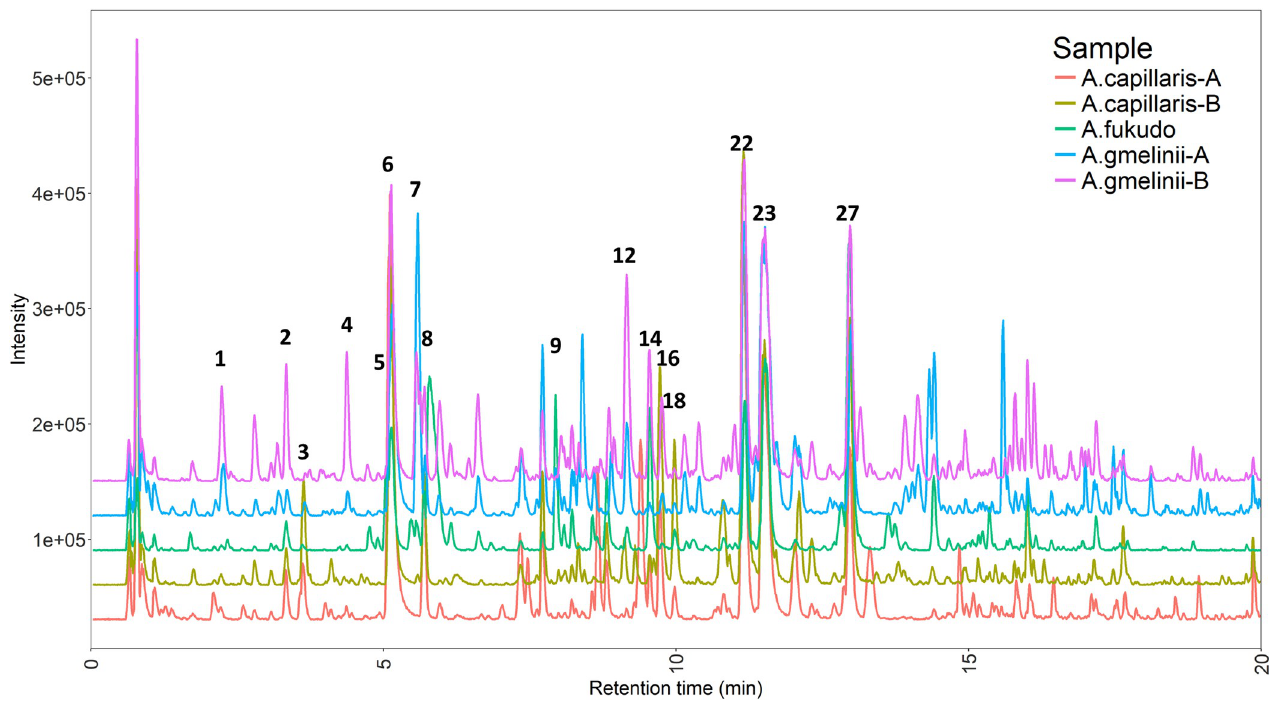
Fig 5. Representative LC-MS base peak ion (BPI) chromatograms of the Artemisia extracts. Tentatively annotated chromatographic peaks are annotated with peak numbers. Gaps between the chromatograms were added to help visualize the differences, so the y-axis values do not equal the absolute intensities.